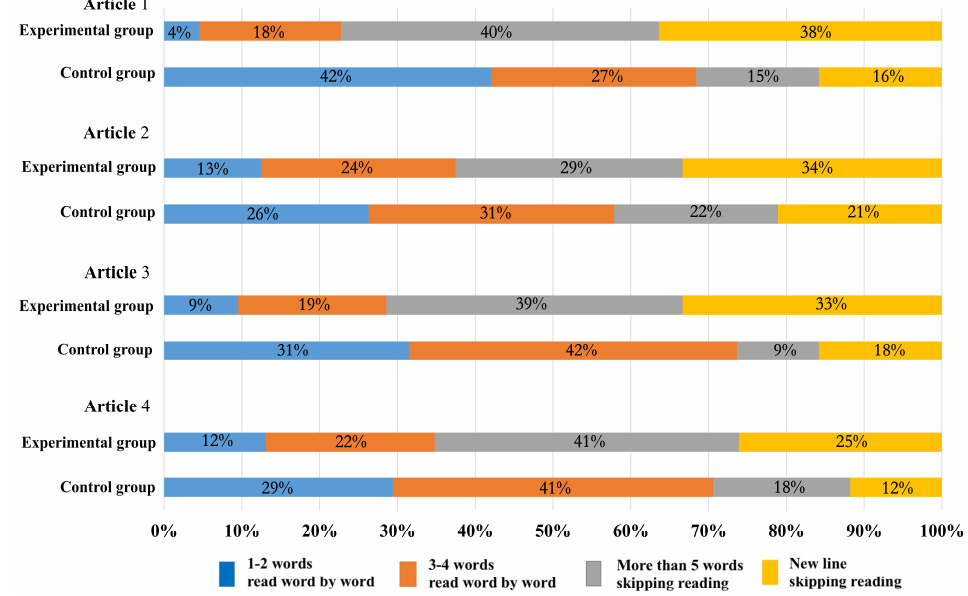
Figure 11. Proportion of skipping reading in the two groups.